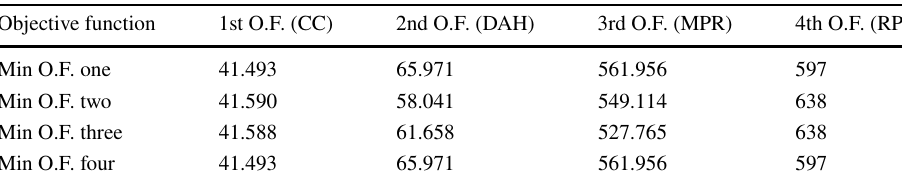
Table 5 Comparison of solutions with the minimum of each objective function